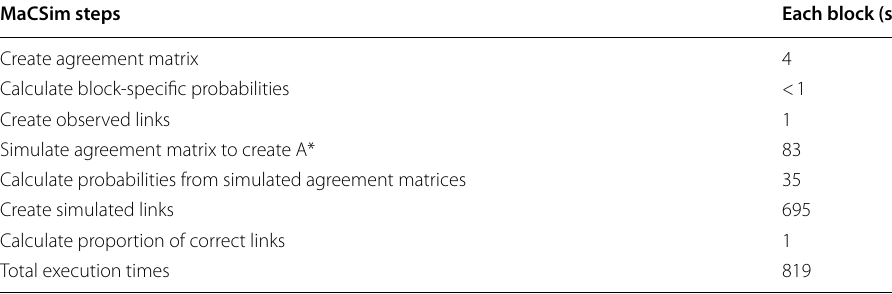
Table 3 Full dataset execution time